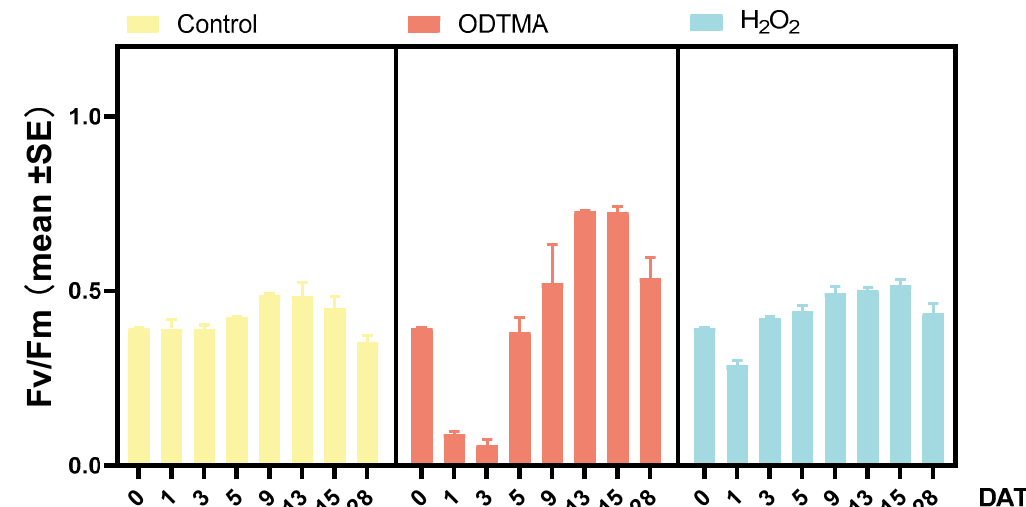
Figure 4. Temporal variations in photosynthetic activity (Fv/Fm) measured in Microcystis cultures maintained in mesocosms and exposed to a single dose of ODTMA-Br (C18) (6.4 μ M) or H 2 O 2 (117 μ M).